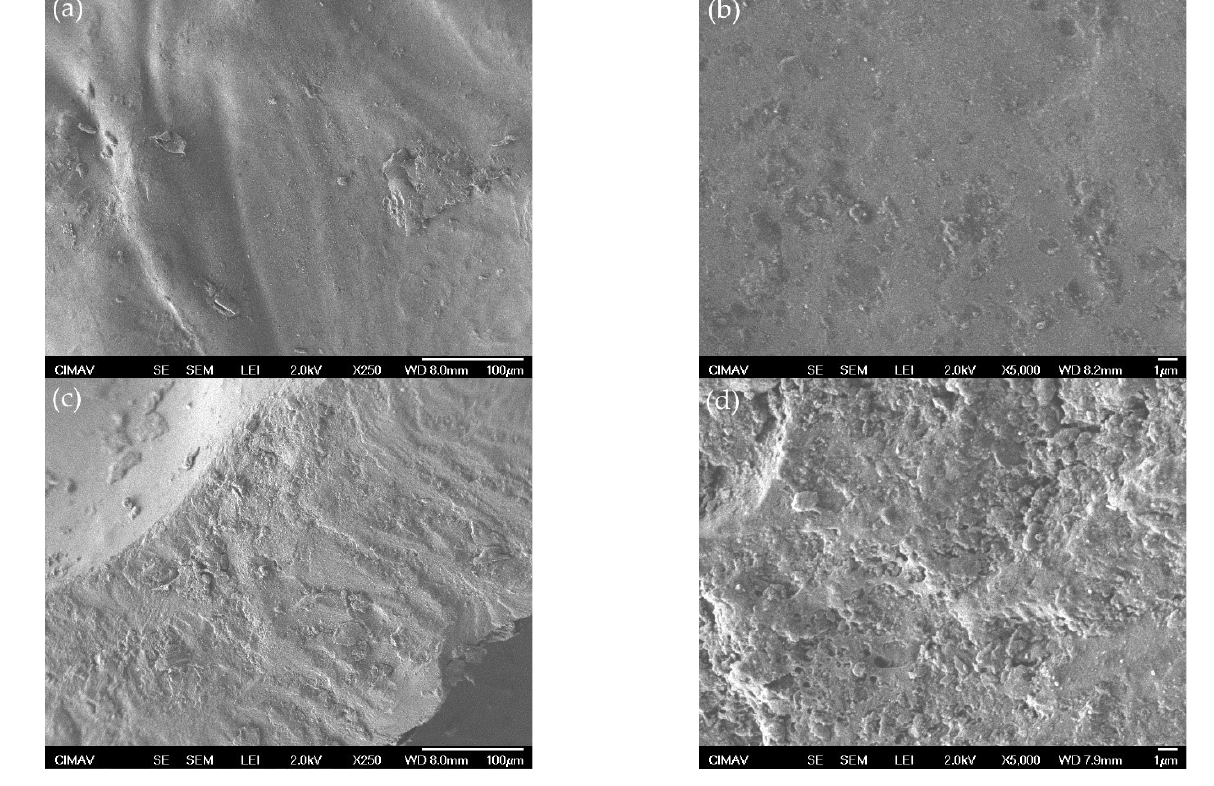
Figure 5. SEM micrographs of the CMC-CS membrane at ( a ) 250× and ( b ) 5000× and the CA50 membrane at ( c ) 250× and ( d ) 5000×.